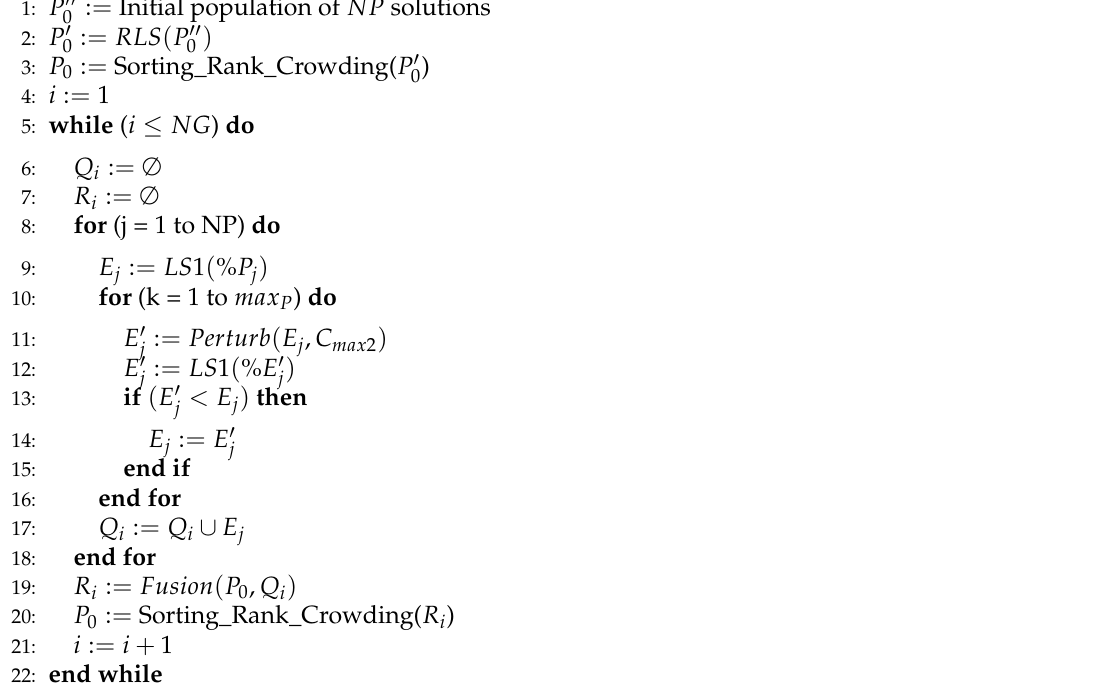
Algorithm 4 Non-Dominated Sorting Iterated Local Search Algorithm